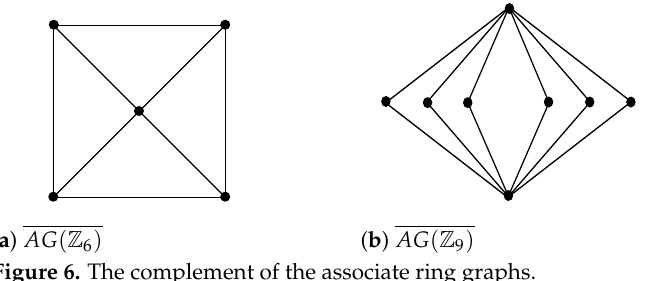
Figure 6. The complement of the associate ring